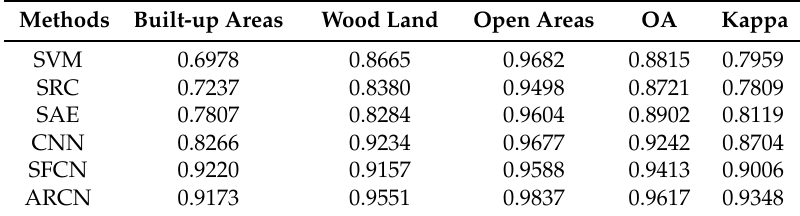
Table 2. Classification results of oberpfaffenhofen with various methods.